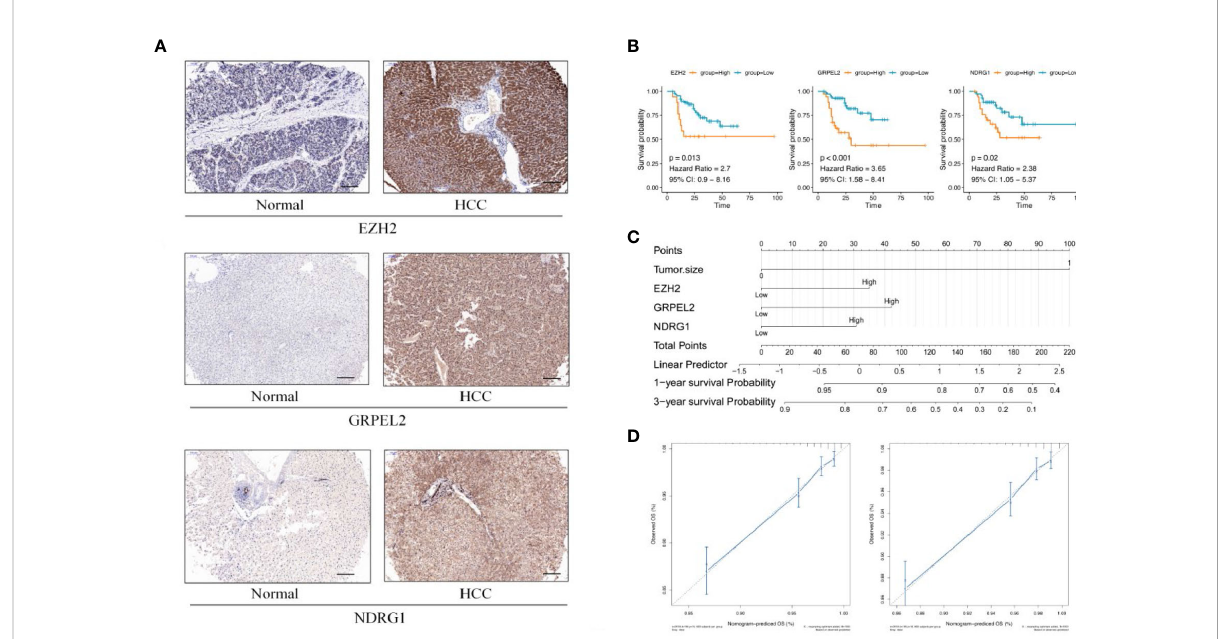
FIGURE 5 Establishment of prognostic model (A) Differential expression between HCC and adjacent non-HCC lesions. IHC image for EZH2, GRPEL2, NDRG1, paired with non-LIHC tissues and LIHC tissues. (B) KM curves of EZH2, GRPEL2, NDRG1. Higher expression of hub genes meant poor prognosis of HCC. (C) Nomogram was for visulizing the prognostic model. Three factors, EZH2, GRPEL2, NDRG1, and tumor size, were enrolled in the prognostic model to predict the survival rate of 1,3 years survival in HCC (D) The nomogram calibration curves of 1-, 3-year survival probabilities. The tool bar =100 m